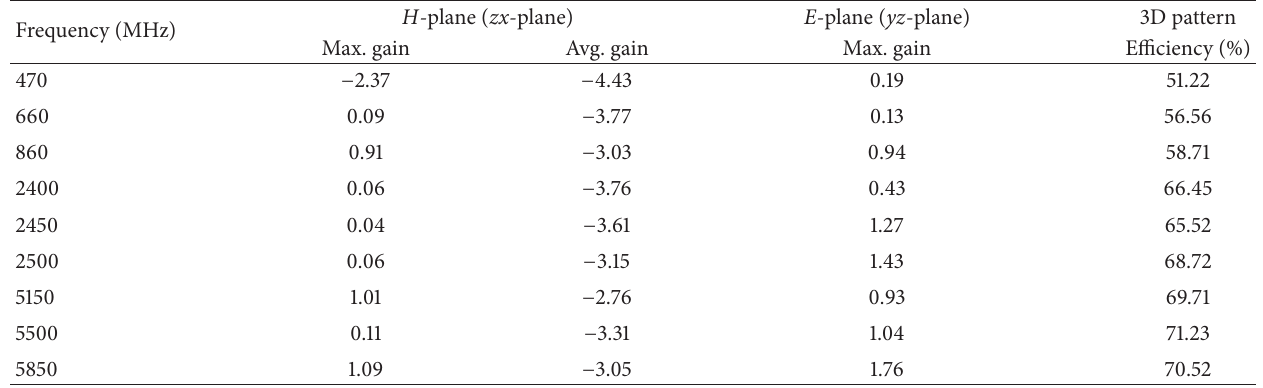
Table 1: The measured antenna gains within the operating bandwidth of the proposed antenna.